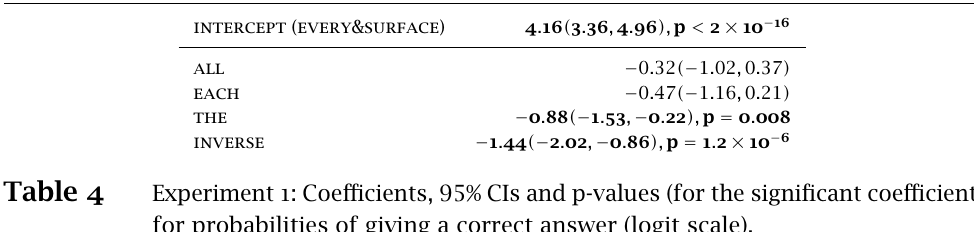
Experiment 1 : Coefficients, 95 % CIs and p-values (for the significant coefficients) for probabilities of giving a correct answer (logit scale).